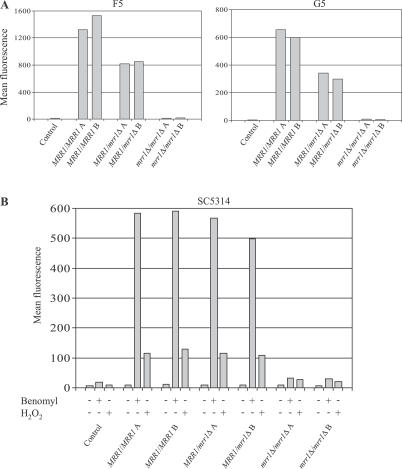

MRR1 Is Required for Constitutive and Induced MDR1 Expression(A) Constitutive MDR1 promoter activity in the drug-resistant clinical isolates F5 and G5 and in heterozygous and homozygous mrr1Δ mutants. The mean fluorescence of two independently constructed derivatives of each parental strain carrying a PMDR1-GFP reporter fusion and grown to log phase in YPD medium was determined by flow cytometry. The parental strains F5 and G5, which do not contain the GFP gene, were included as negative controls.(B) Benomyl- and H2O2-induced MDR1 promoter activity in strain SC5314 and its mrr1Δ derivatives. Two independently constructed reporter strains of each parental strain carrying a PMDR1-GFP reporter fusion were grown in the absence (-) or presence (+) of benomyl or H2O2 as detailed in the experimental procedures and the mean fluorescence of the cells was determined by flow cytometry. The parental strain SC5314, which does not contain GFP, was included to control for background fluorescence.